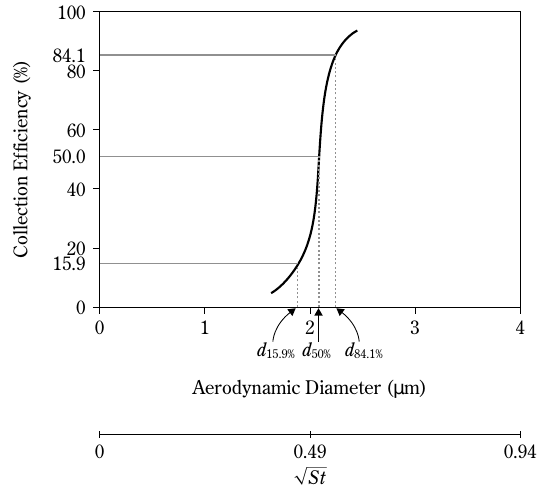
Idealized collection efficiency curve for a single round- nozzle impactor